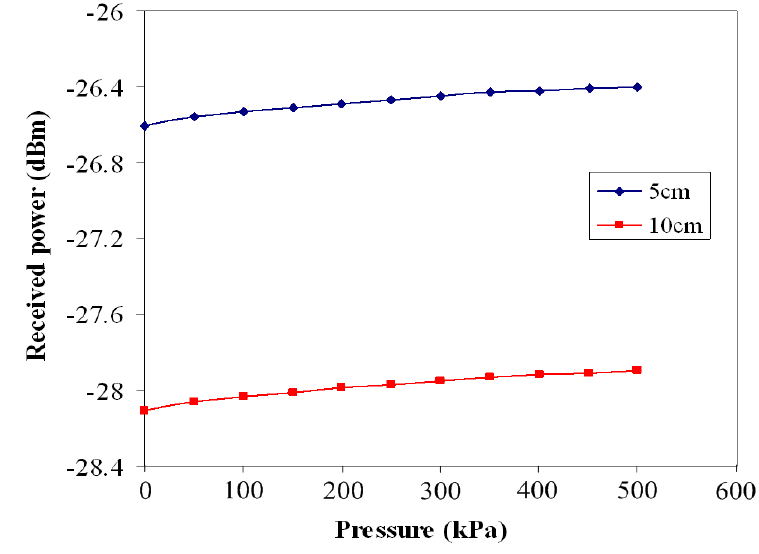
Figure 15. Received power of the receiver at the different transmission